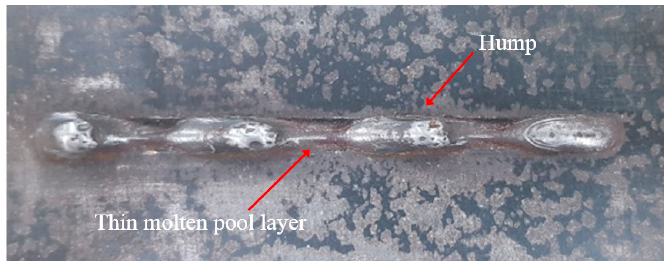
Figure 7. Formation of humping bead with a WFR of 9 m/min.